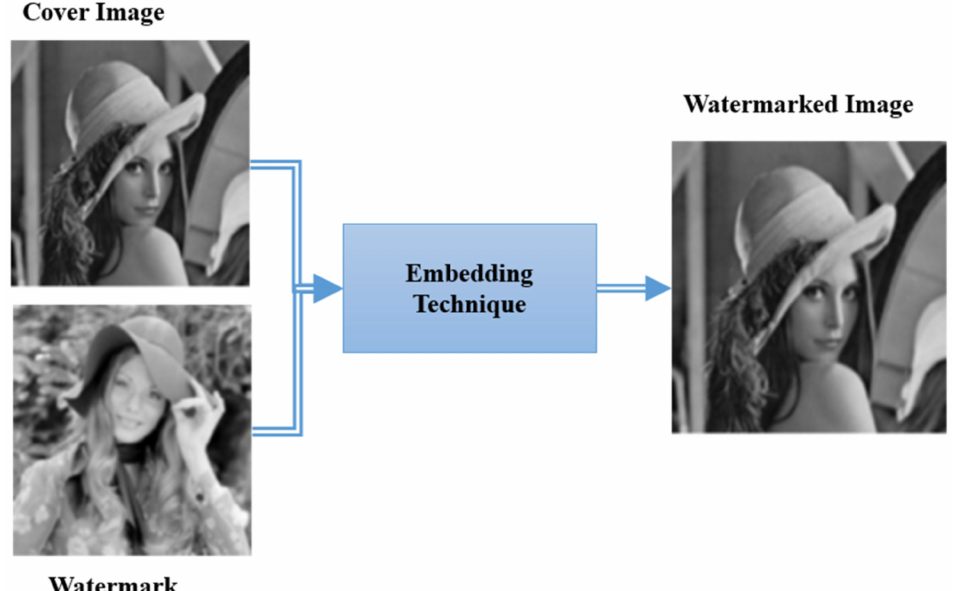
Figure 2. The Structure of